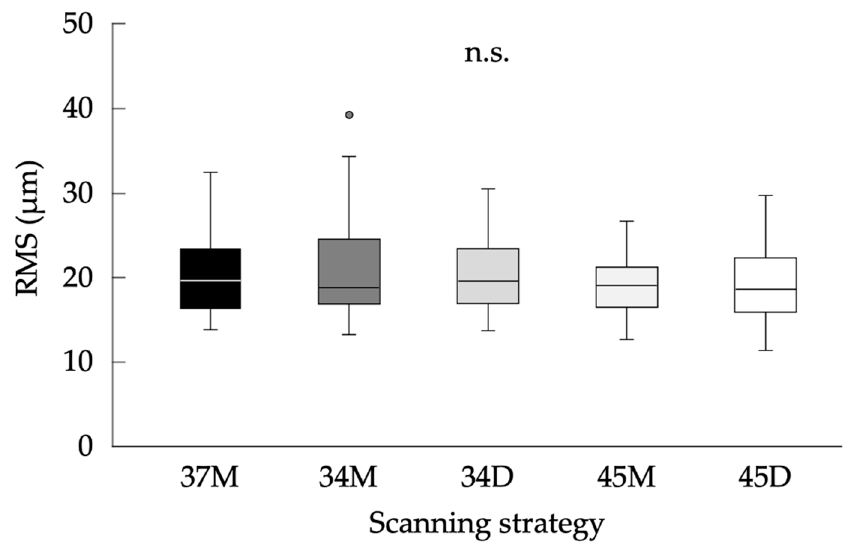
Figure 7. Results of the comparison of precision for full-arch model among five scanning strategies. The gray dot above the box plot of 34M indicates the outlier. n.s.: not significant.